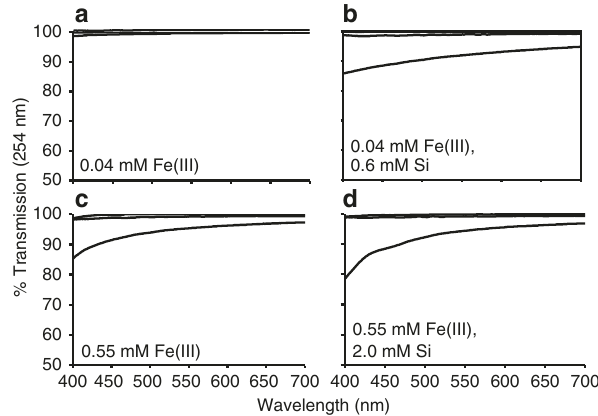
Fig. 5 PAR transmission in cell-free, Fe(III) – Si-supplemented growth media. Transmission of photosynthetically active radiation (PAR: 400 – 700 nm; in %) through 0.04 – 0.55 mM Fe(III) ( a – d ) and 0.6 – 2.0 mM Si ( b , d ) supplemented growth media. Upper curve — dissolved. Middle curve — nanoparticulate/dissolved. Bottom curve — colloidal/nanoparticulate/ dissolved. Similar transmission of UV-C radiation in dissolved and nanoparticulate/dissolved fractions as show by overlap of the upper and